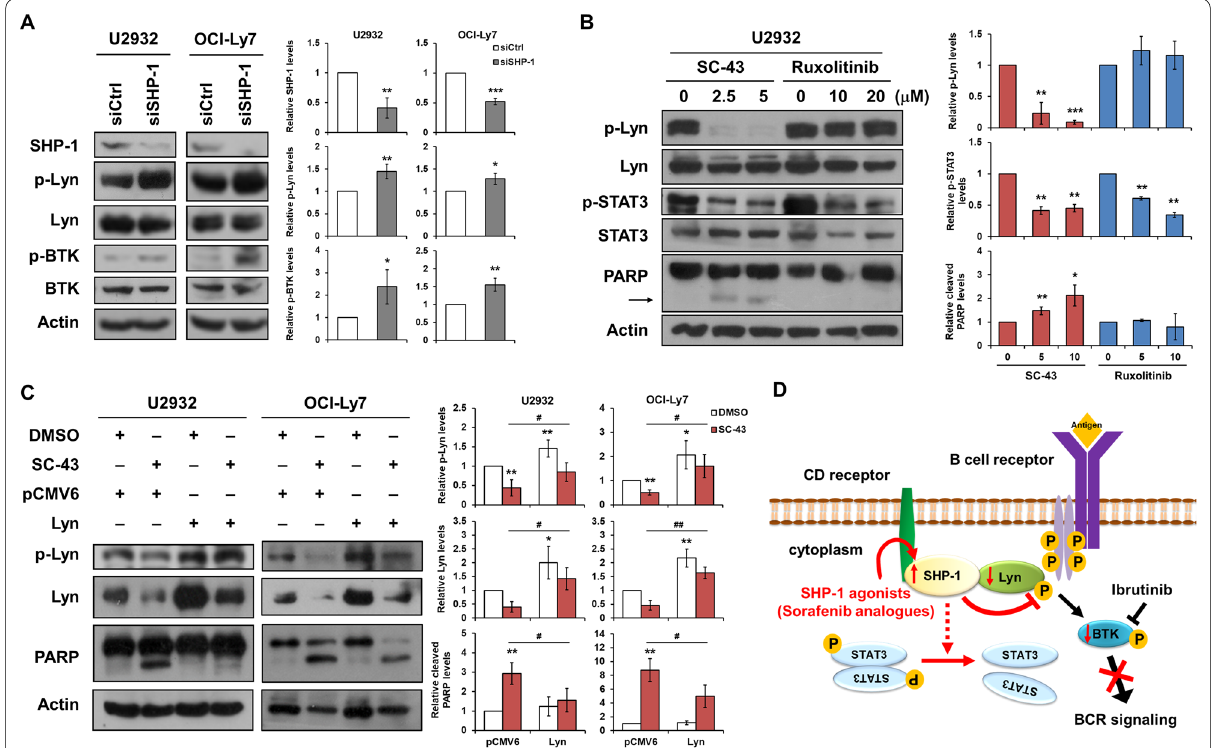
Fig. 5 SHP‑1 agonist induces cell apoptosis through Lyn. A Whole‑cell extracts of U2932 and OCI‑Ly7 transfected with siRNAs against SHP‑1 or control were assessed by Western blot analysis (left). The quantitative results of blotting were shown (right). B U2932 cells treated with SC‑43 or ruxolitinib at indicated doses for 24 h were examined by Western blot analysis (left). The quantitative results of blotting were shown (right). C U2932 and OCI‑Ly7 cells were transfected with Lyn‑expressing or control plasmids for 48 h. The transfected cells were further treated with 10 μM SC‑43 or DMSO for 24 h and examined by Western blot analysis (left). The quantitative results of blotting were shown (right). D In the present study, our data indicated that SHP‑1 agonists (sorafenib analogues such as SC‑43 and SC‑60) enhanced SHP‑1 activity and further reduced phosphorylation of Lyn and BTK. Dephosphorylation of Lyn and BTK inhibited cell survival signaling leading to cell apoptosis. In addition, SHP‑1 agonists also dephosphorylated STAT3 as previously reported which might partly contribute to cell growth inhibition. Data are representative of three independent experiments. Student’s t ‑test, * P < 0.05; ** P < 0.01; *** P < 0.001; # P < 0.05; ## P <